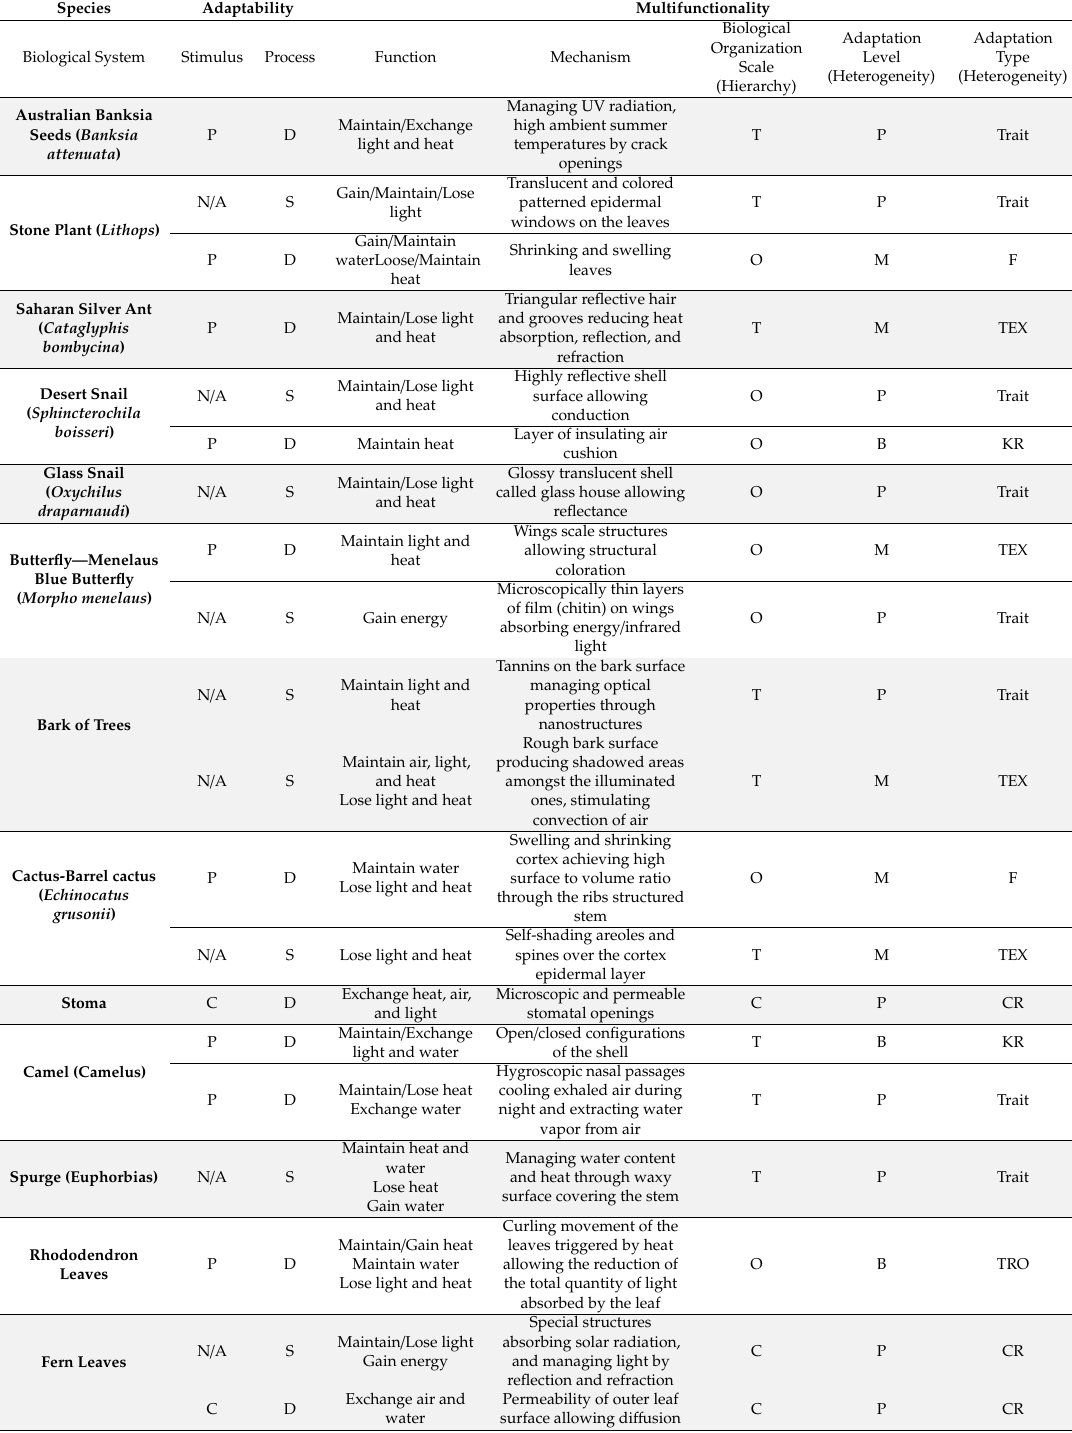
Table 3. A preliminary mapping of several biological systems through the systematic